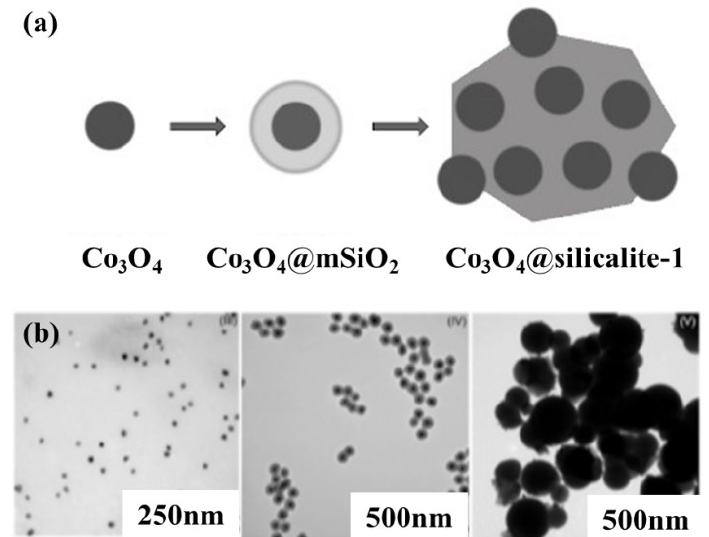
Figure 5. ( a ) Schematic bottom-up synthesis of Co@SiO 2 and Co@Silicalite-1 via a solvothermal method and ( b ) morphological TEM images of Co@SiO 2 and Co@Silicalite-1 (from left to right). Figure reproduced from Ilsemann et al. [60], Cobalt@Silica Core-shell Catalysts for Hydrogenation of CO/CO 2 Mixtures to Methane; copyright from ChemCatChem , John Wiley and Sons,